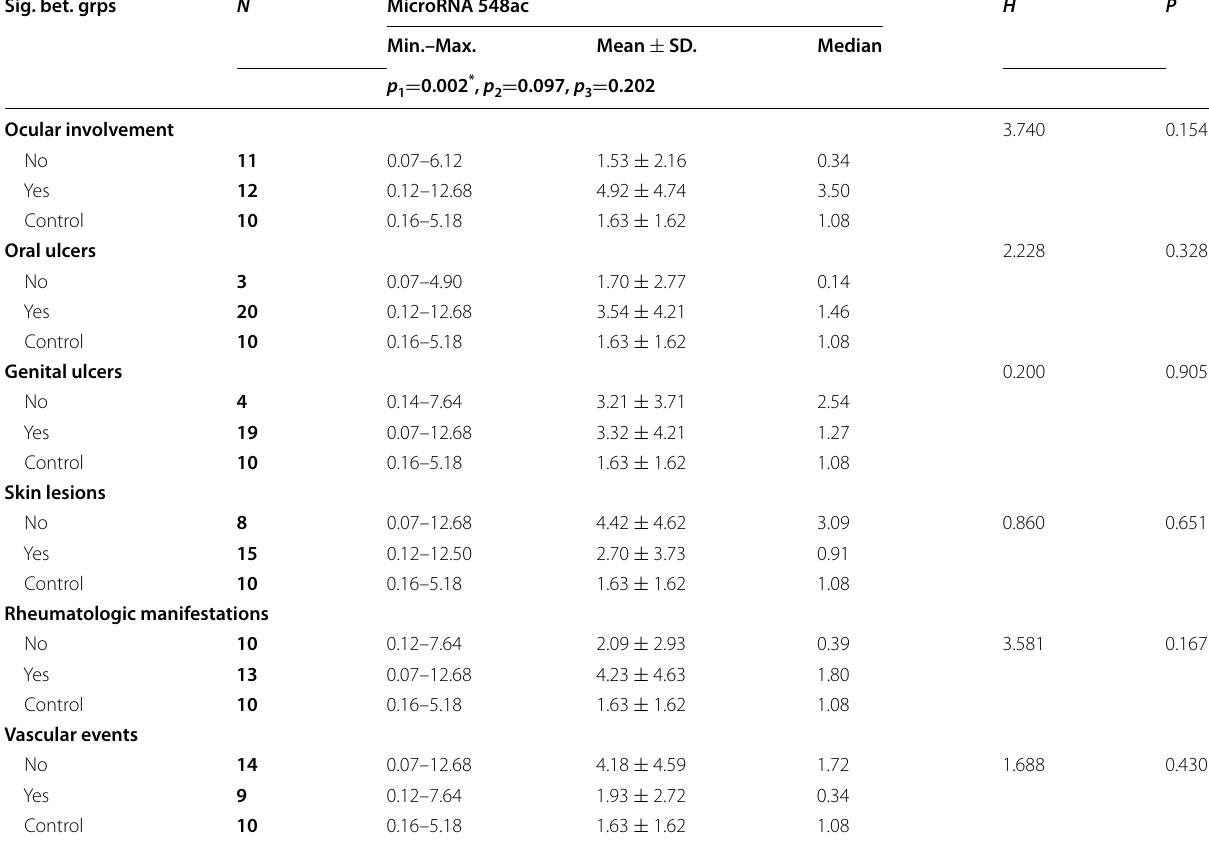
H H for Kruskal Wallis test, Pairwise comparison bet. each 2 groups was done using post hoc test (Dunn’s for multiple comparisons test), p p value for association between different categories